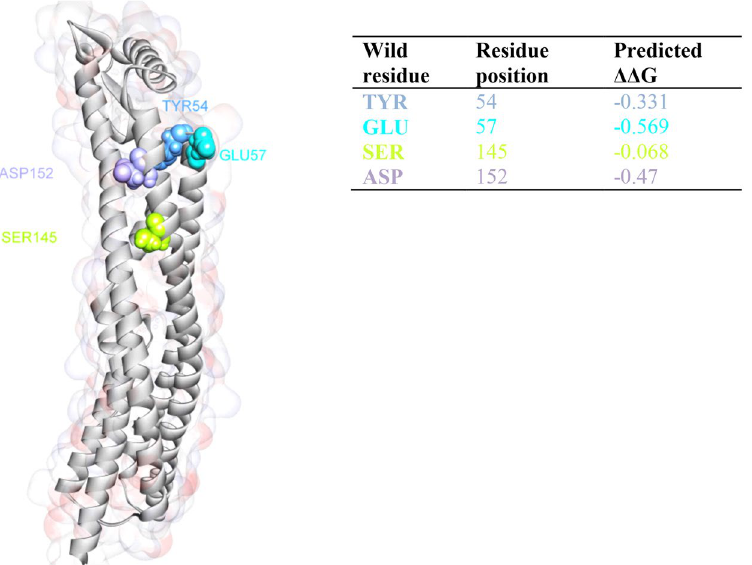
Figure 7. Site-directed mutagenesis analysis of conformational epitope highlighting the most influential